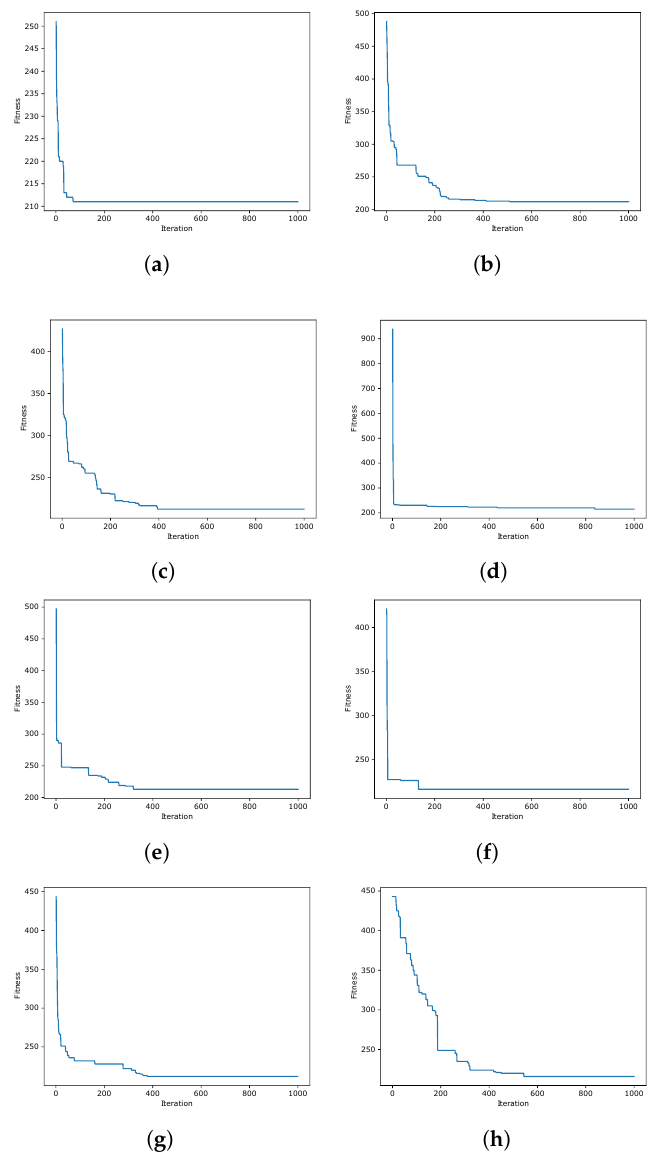
Figure 5. GWO instances coverage when resolving the scp55 instance of the SCP. Instance